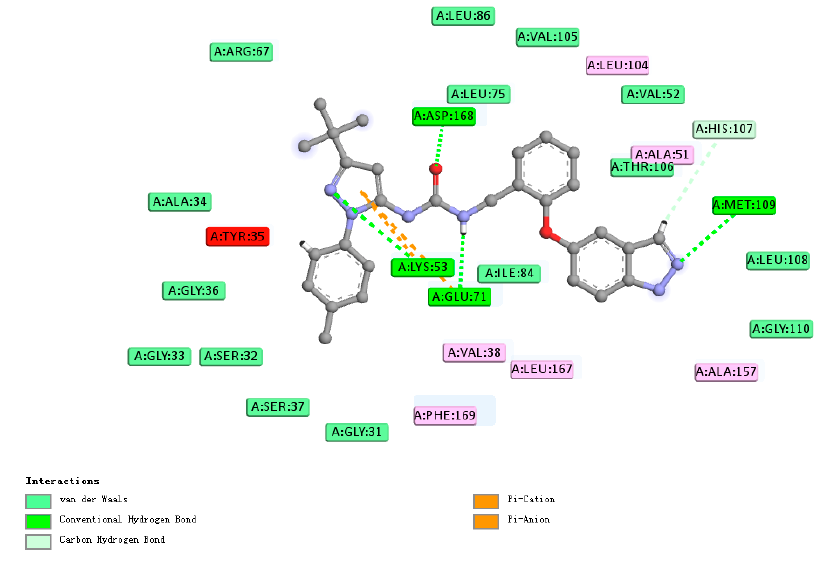
Figure 3. Structure of compound 25a and a two-dimensional p38 MAPK α / 25a interaction map.